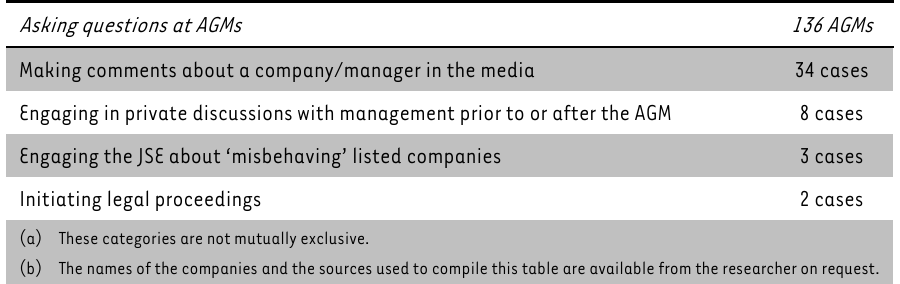
TABLE 2: Botha’s main modus operandi over the period May 2002 to July 2014 (a) & (b)